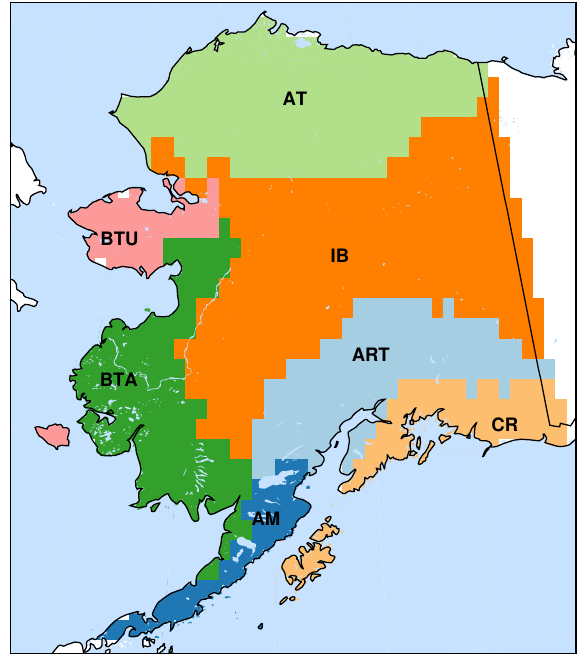
Fig. 5. Alaska ecoregions following the scheme used by the Alaska Fire Service. IB=Intermontane Boreal; AT=Arctic Tundra; ART=Alaska Range Transition; BTA=Bering Taiga; BTU=Bering Tundra; CR=Coastal Rainforest; AM=Aleutian